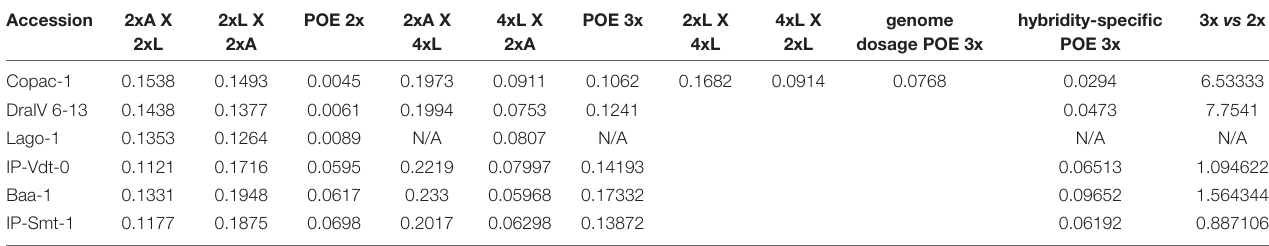
TABLE 2 | Hybridity-associated parent-of-origin effects on seed size in F1 hybrid triploids compared with their diploid counterparts.